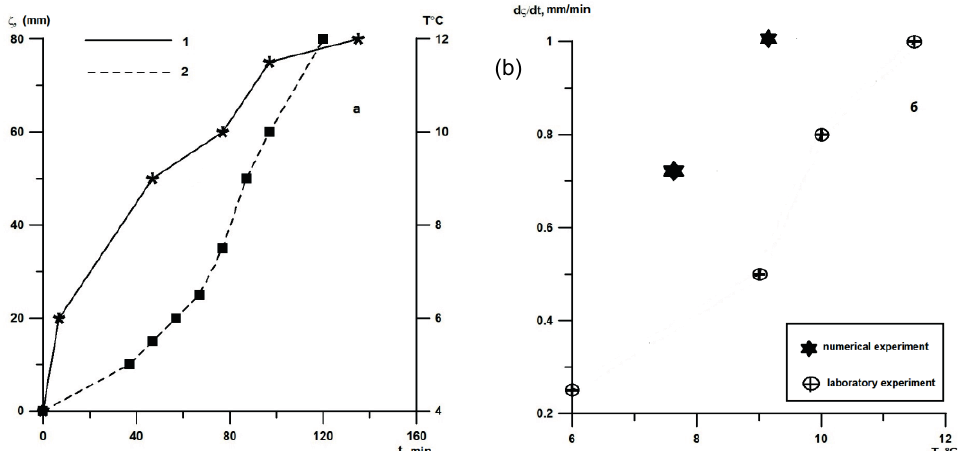
Fig. 3 The dependencies of temperature (1) and erosion (2) of the ambient soil from time according to laboratory experiment (a), the rate of erosion from the soil temperature according to laboratory and numerical experiments